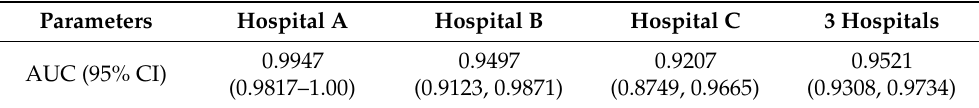
Table 4. Model benchmark using retrospective approach for